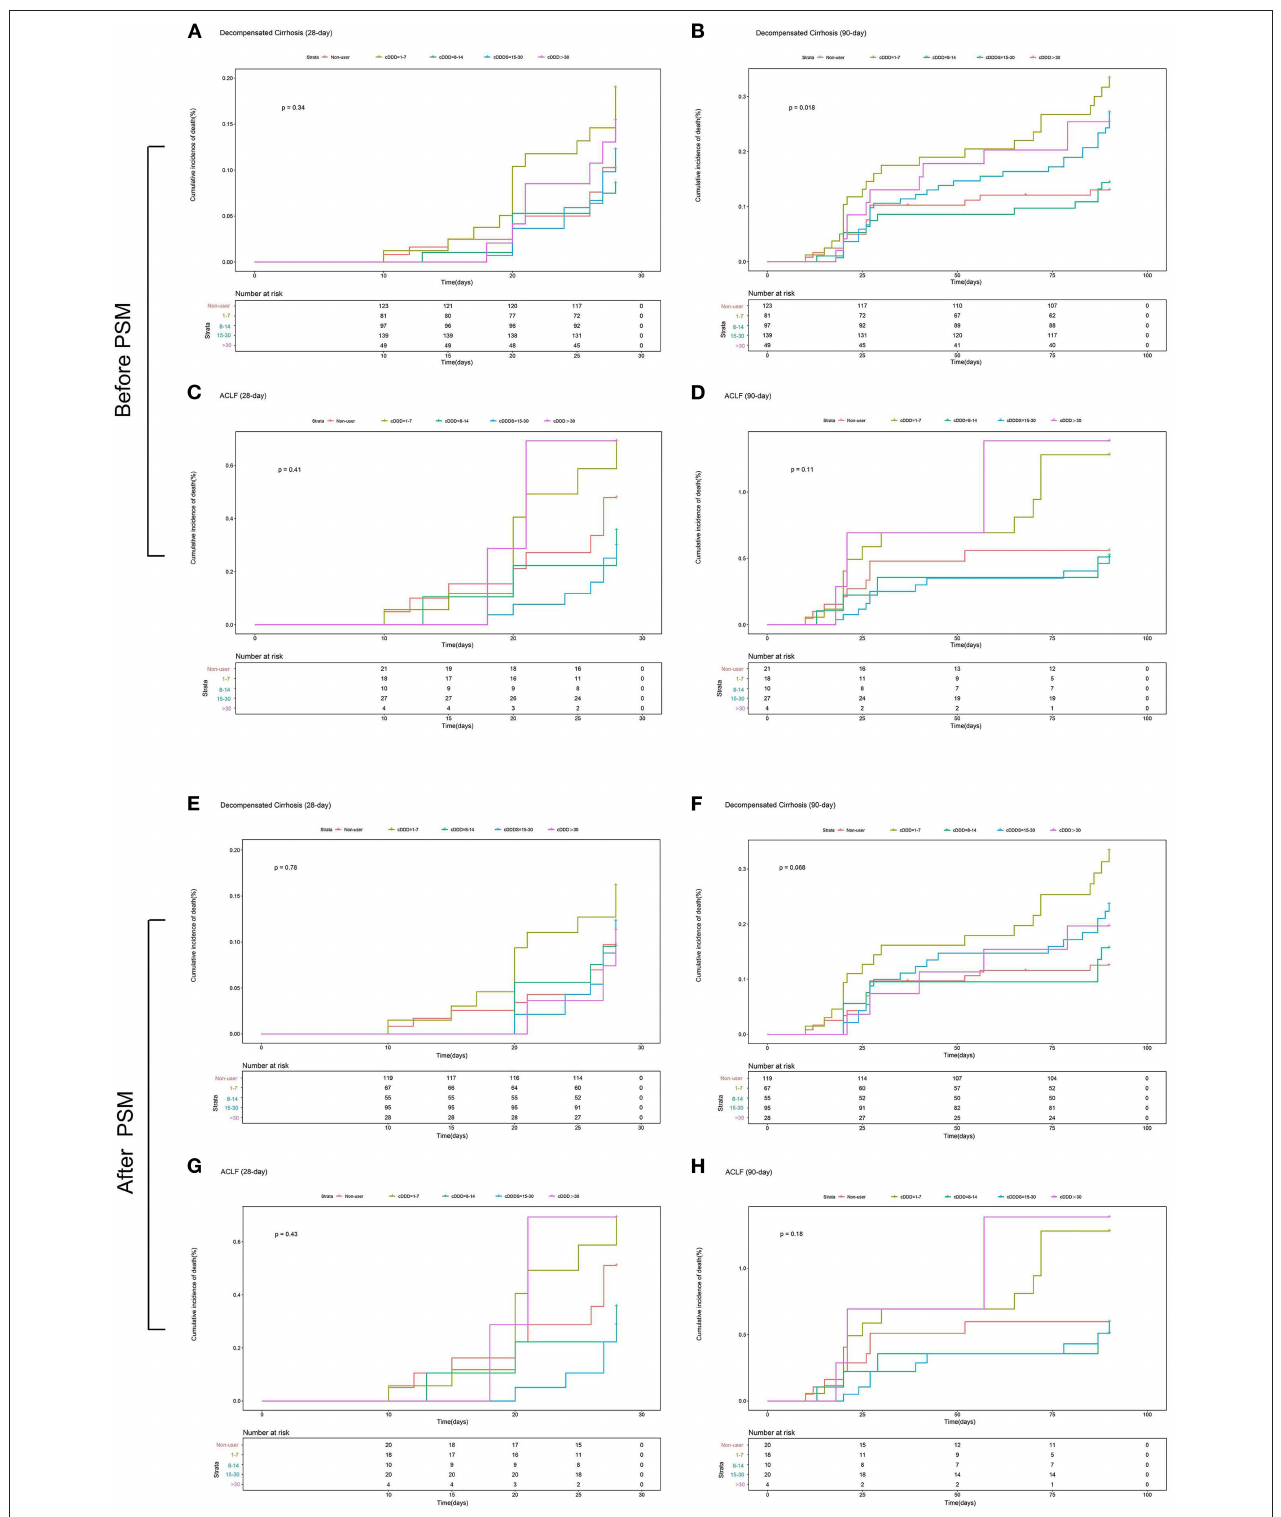
FIGURE 5 | The 28-day or 90-day cumulative incidence of death of patients with and without ACLF with different doses or without PPI treatment during hospitalization. (A) The 28-day cumulative incidence of death of patients with decompensated cirrhosis with different doses or without PPI treatment before